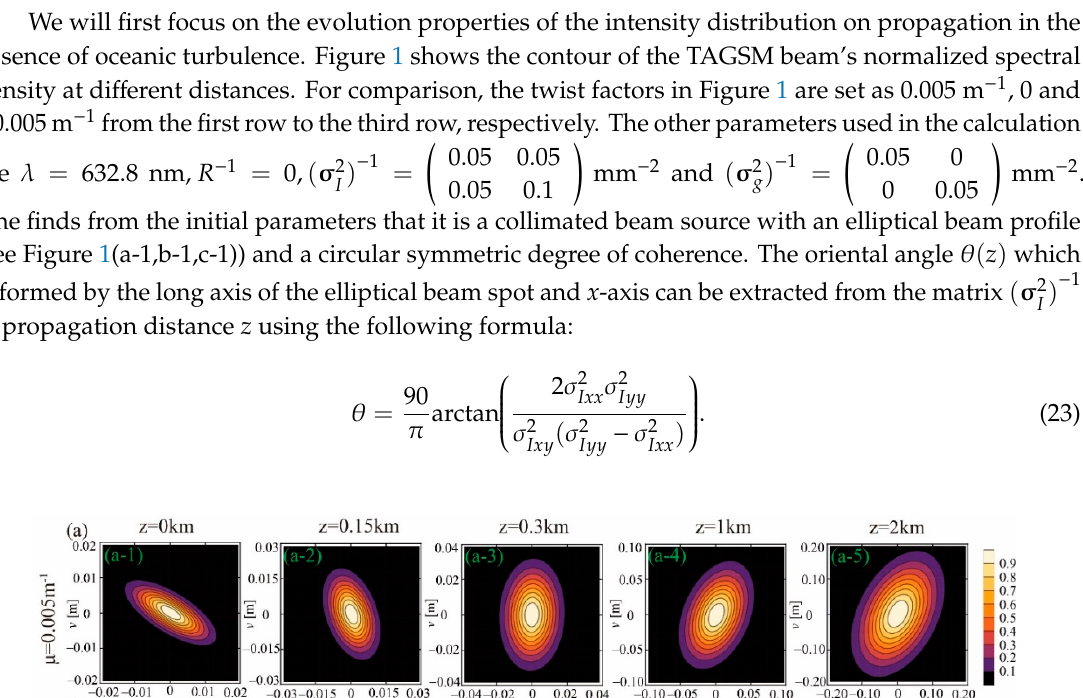
Figure 2. Normalized spectral density (contour graph) of a TAGSM beam at several propagation distances z in oceanic turbulence ( =-2.5 ω